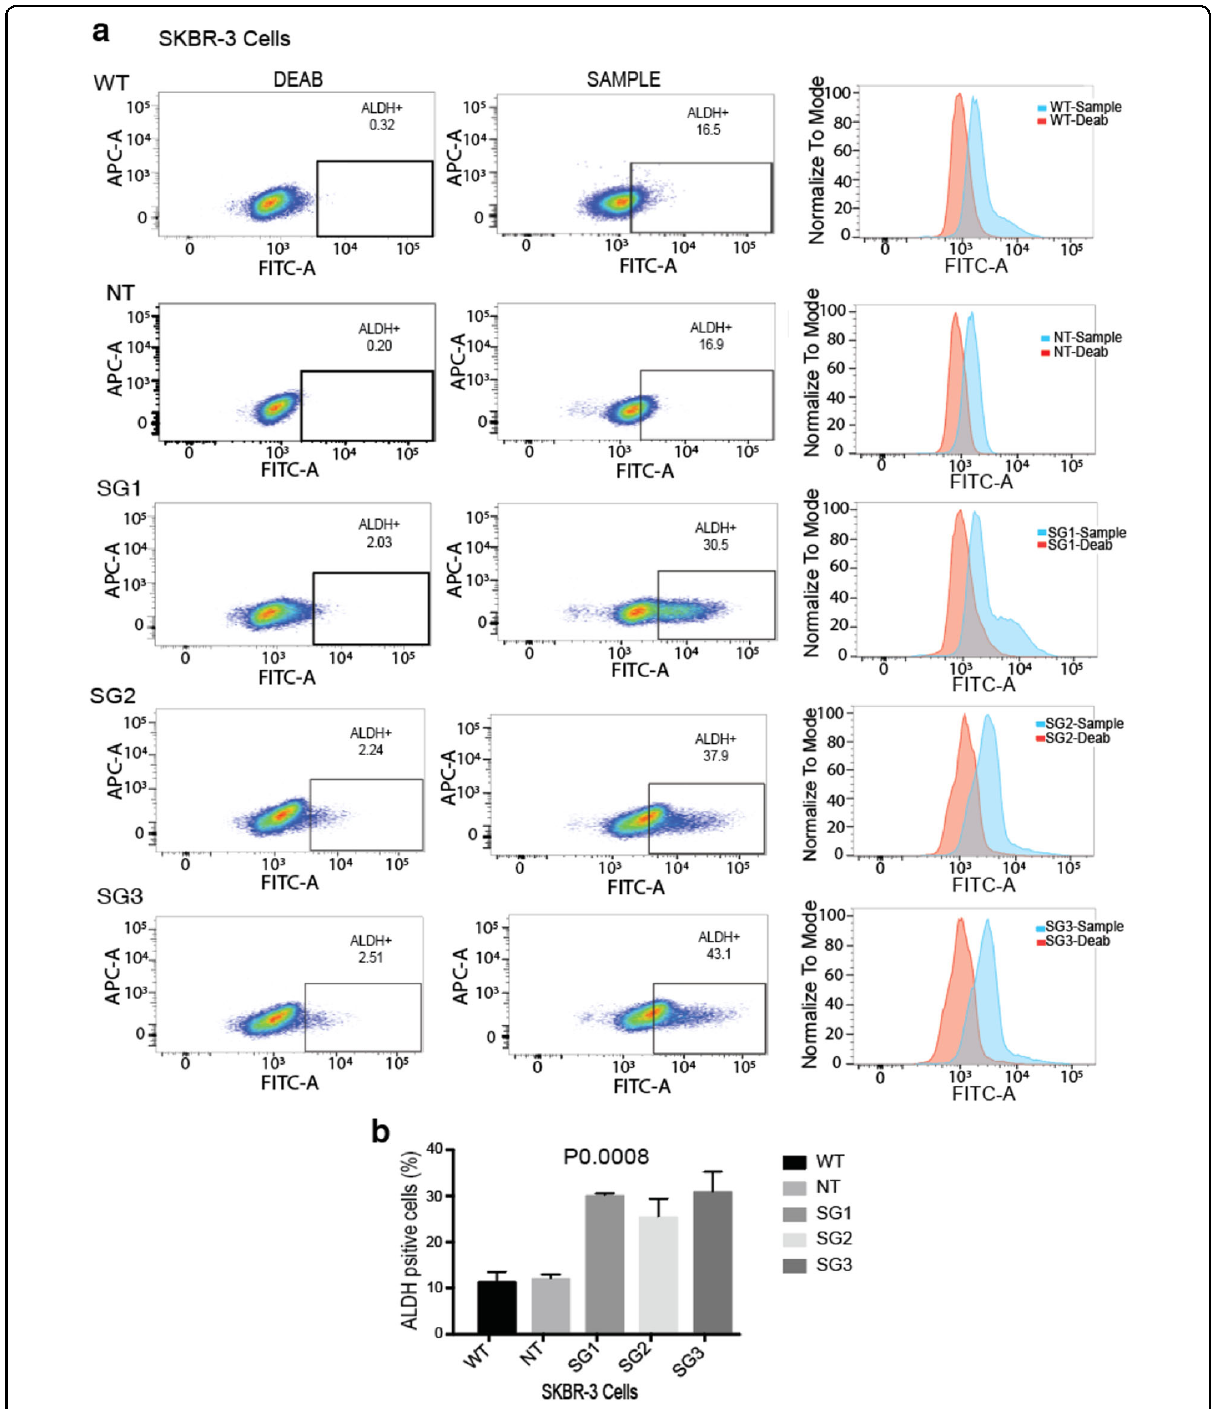
Fig. 4 Loss of PRLR in SKBR-3 breast cancer cells augmented breast cancer stem-like cells markers expression. a ALDH + BCSCs were determined using fl ow cytometry in SKBR-3/WT, SKBR-3/NT, and SKBR-3/PRLRKO (SG1, SG2, and SG3) cell lines. Left panels, representative images of dot plots (DEAB treated) and samples. Right panels show histograms. b Quanti fi cation analysis of ALDH + BCSCs in SKBR-3/WT, SKBR-3/NT, and SKBR- 3/PRLRKO (SG1, SG2, and SG3) cell lines expressed as mean ± SEM of duplicates of three independent experiments, *** P 0.0008 (one-way